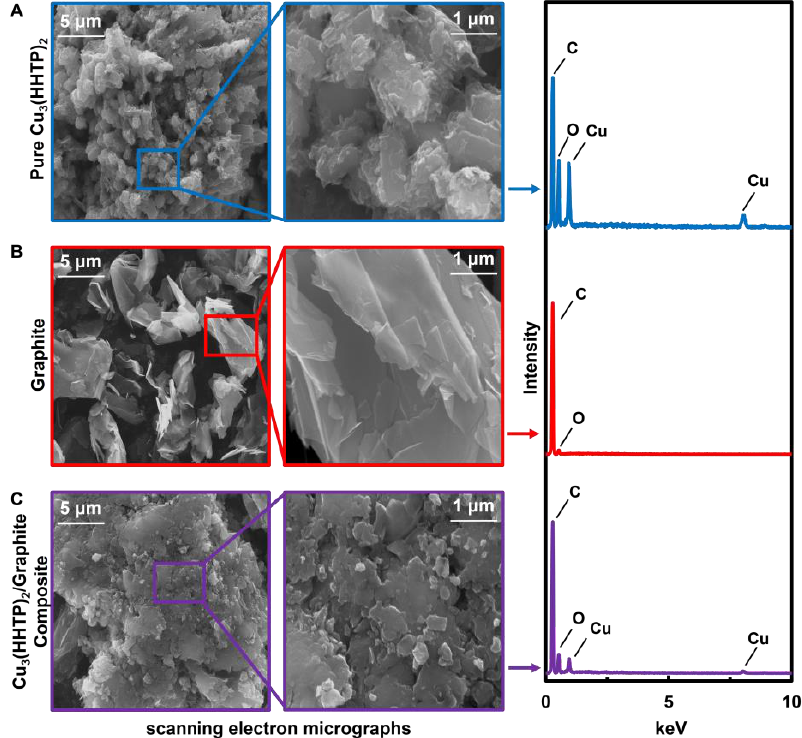
Figure 2. Scanning electron microscopy (SEM) micrographs and energy dispersive X-ray spectroscopy (EDS) analysis of pure MOFs, graphite, and Cu 3 HHTP 2 /graphite blend. From left to right: ( A ) Microcrystals of pure Cu 3 HHTP 2 MOFs at 3200× and 20,000× magnification and corresponding EDS analysis; ( B ) Graphite at 3200× and 20,000× magnification and corresponding EDS analysis; ( C )